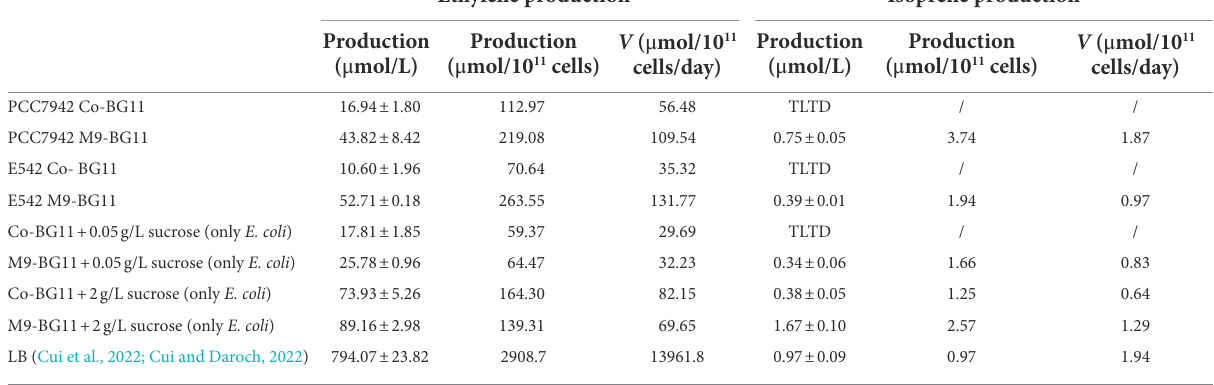
TABLE 3 Ethylene and isoprene production in consortium